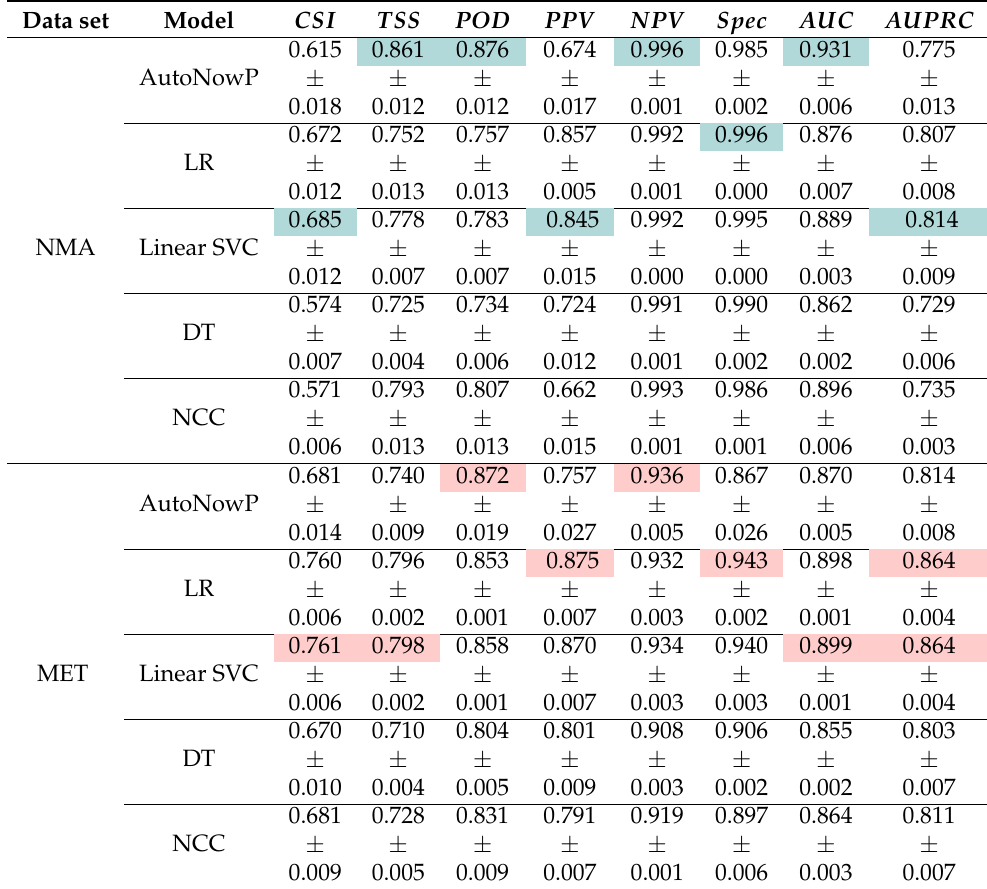
Table 4. Comparative results between AutoNowP and other classifiers. 95% CIs are used for the